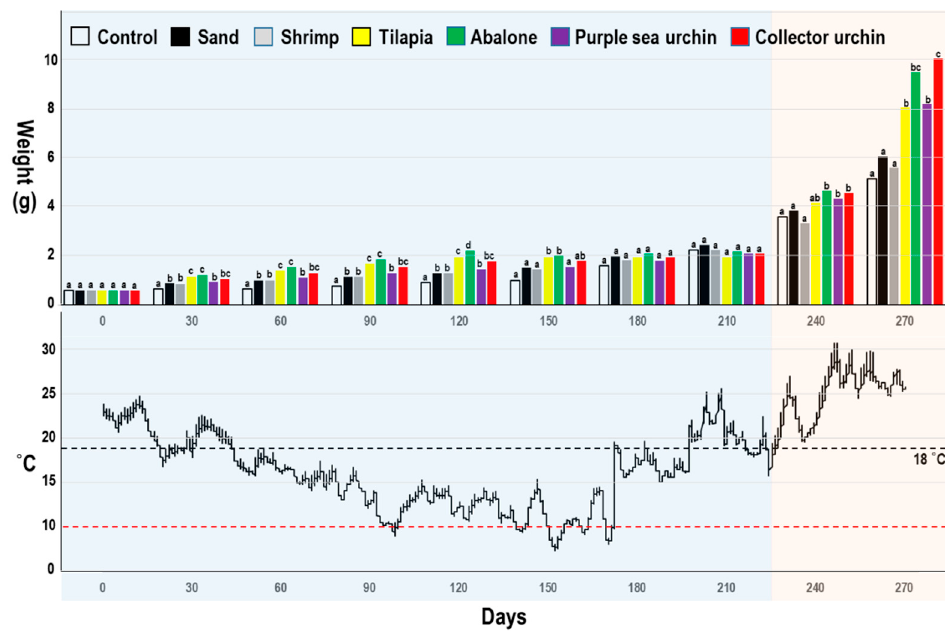
Figure 6. Laevistrombus canarium . Outdoor polyculture experiments. Mean ( ± sd) weight of juveniles at various periods (0 to 270 days post initiation of the experiment) coculture treatments (control, sand, cocultured with shrimp, tilapia, abalone, purple sea urchin, or collector urchin). Mean daily outdoors water temperature values during the experimental period. Different letters indicate statistically significant differences (Tukey’s HSD; p < 0.05) between coculture treatments at each sampling day (0 to the 270th day post-initiation of the experiment). Table 4. Laevistrombus canarium . Mean ( ± sd) of weight, shell length, shell width, shell depth, survival rate, and daily growth rate of juveniles after 270 days of coculture treatments (control, sand, cocultured with shrimp, tilapia, abalone, purple sea urchin, or collector urchin) at outdoors water temperature.